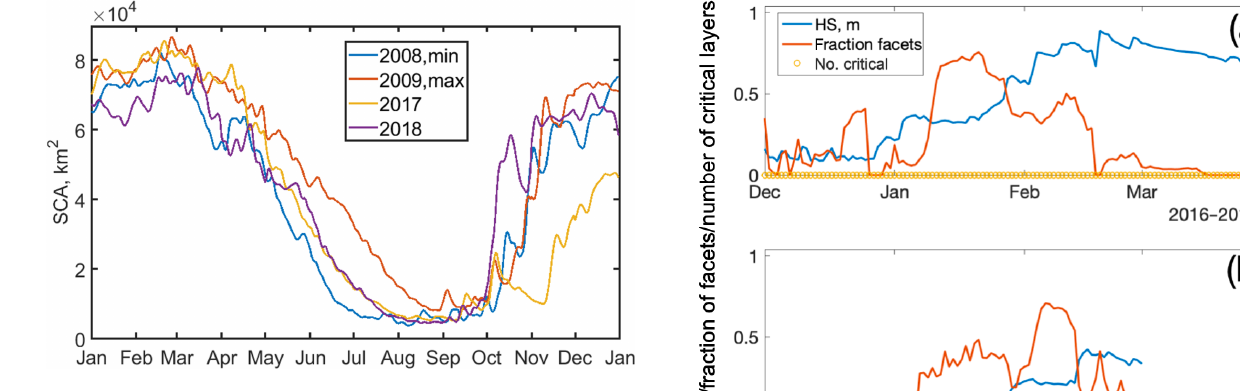
Figure 8. Time series of snow covered area from spatially and tem- porally interpolated MODSCAG (Rittger et al., 2020), an input for ParBal, for 4 selected years across the region. Years 2008 and 2009 had the lowest and highest values on 1 July over the period of record from 2001 to 2018, while 2017 and 2018 comprise the AKAH sta- tion study period.